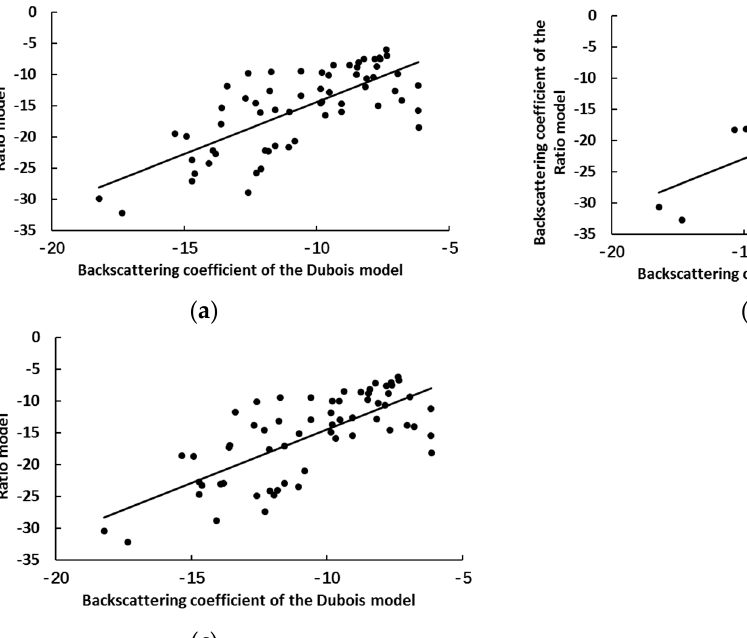
Figure 9. Scatter plot of backscattering coefficient of VV polarization of Dubois model and ratio model ( a ) VWC; ( b ) NDVI; ( c ) EVI. Table 3. Fitting result of backscattering coefficient.